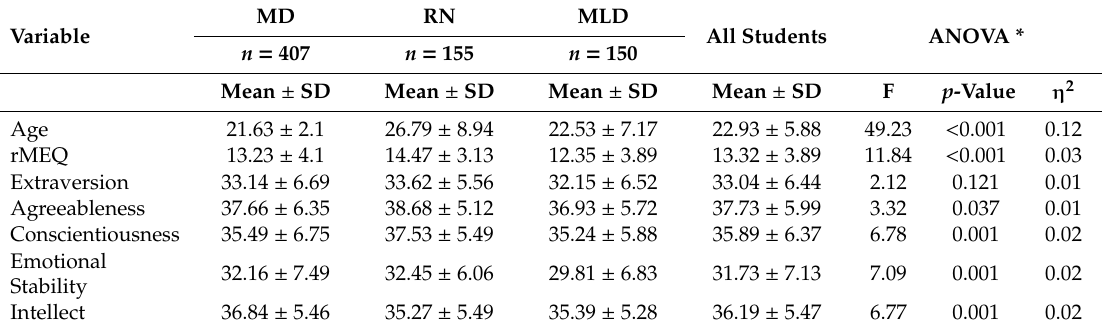
Table 3. Descriptive statistics of the reduced Morningness-eveningness questionnaire (rMEQ) and the domains of the IPIP 50 Big-Five questionnaire and the di ff erences between the groups ( n =